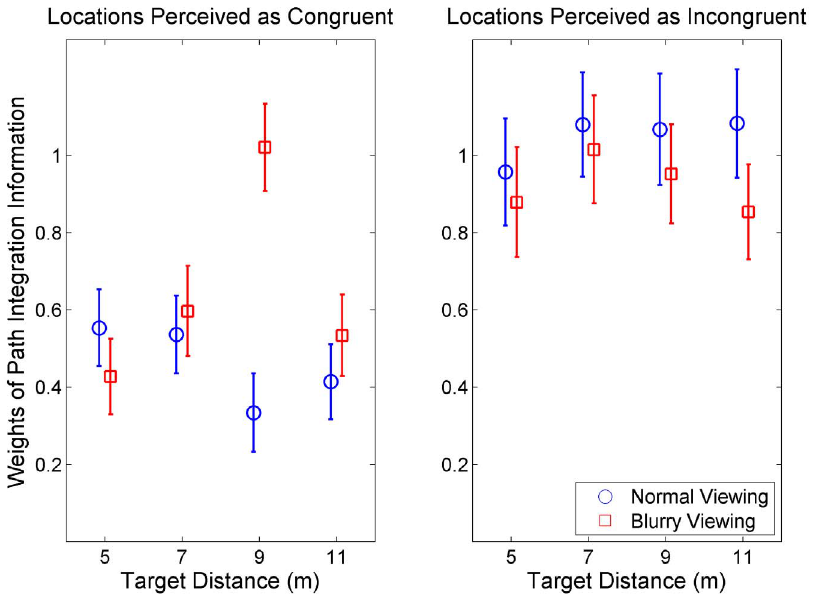
Figure 4. Weight given to path integration by individual participants. Amount of weight that individual subjects gave to location information obtained by path integration when viewed and walked locations were perceived as congruent versus incongruent.